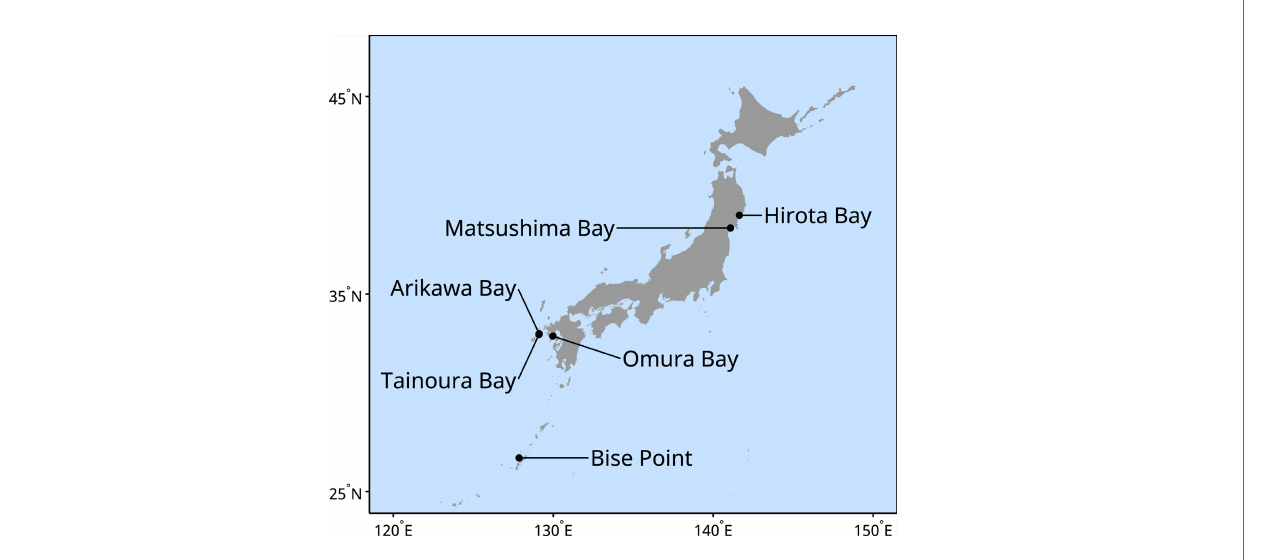
FIGURE 1 | Location of the sites monitored during the